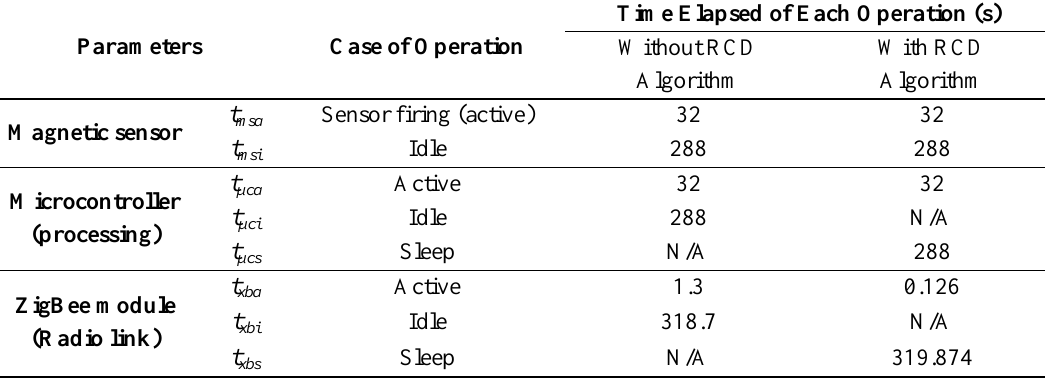
Table 4. Time elapsed of different components in the sensor node related to Equations (6) and